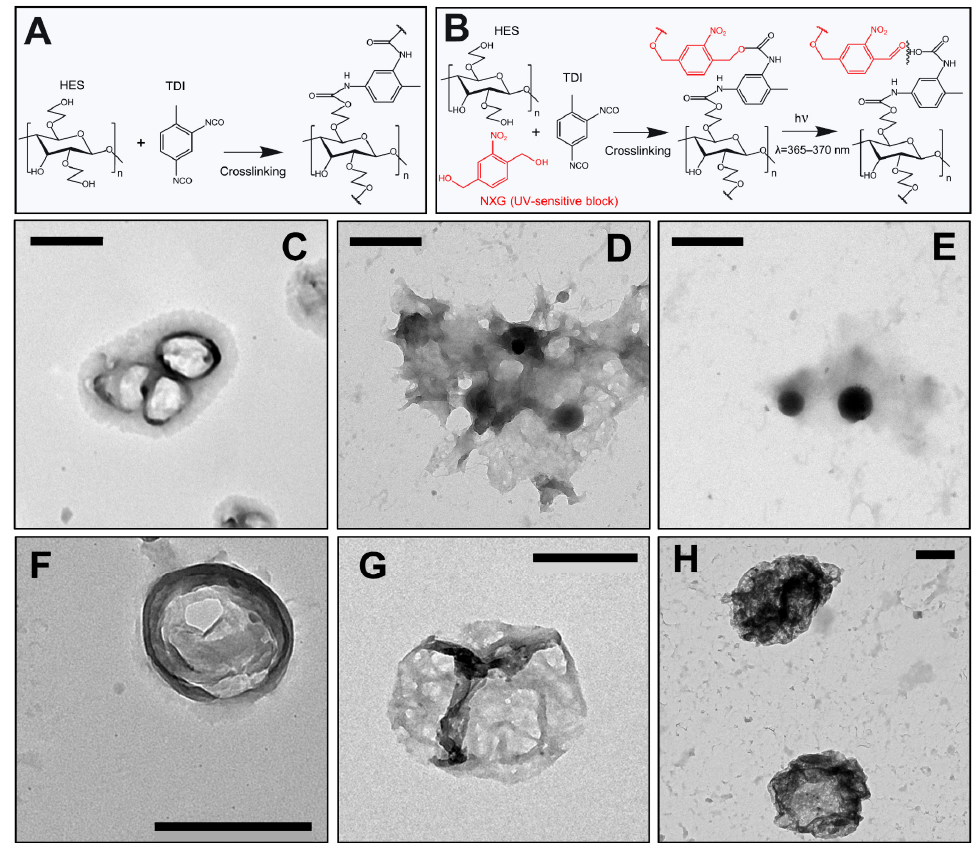
Figure 3. ( A ) Crosslinking of the HES chains with usual crosslinker. ( B ) Crosslinking of the HES chains with photocleavable co-crosslinker, and the UVA light induced cleavage of the cross bonds. Transmission electron microscopy (TEM) images of the formulations 1144d ( C ), 1144d in EtOH/water ( D ), 1144d in EtOH + 1%Tween 20 ( E ), 1144g ( F ), 1144g + UVA ( G ), 1212 ( H ). Scale bars correspond to 500 nm.